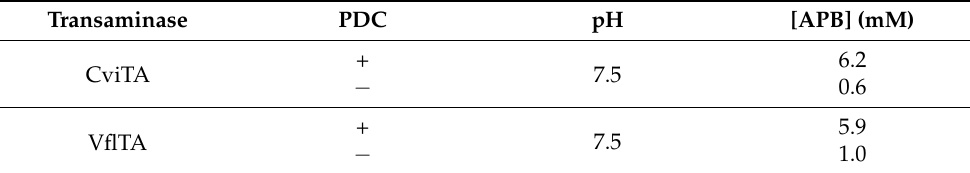
Table 1. Transaminase screening for 3-APB synthesis. Reaction conditions: 24 h; 30°C; 4-PB 10 mM;